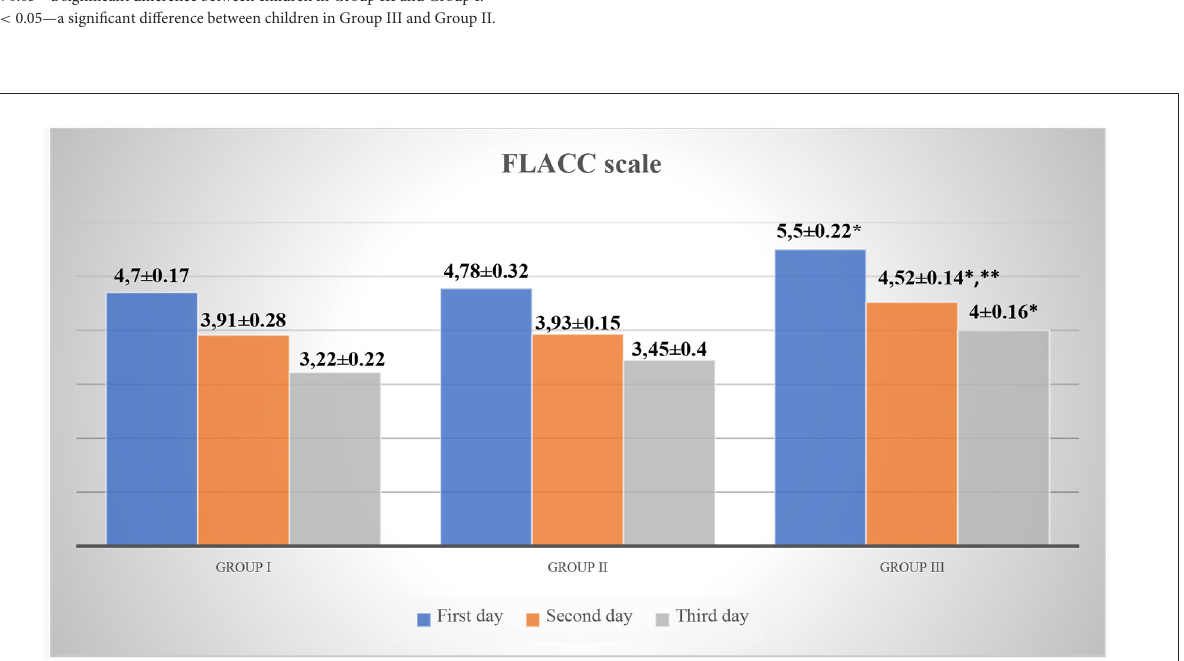
± 0.2, p < 0.05, t2 = 2.655). On the 3nd day of hospital